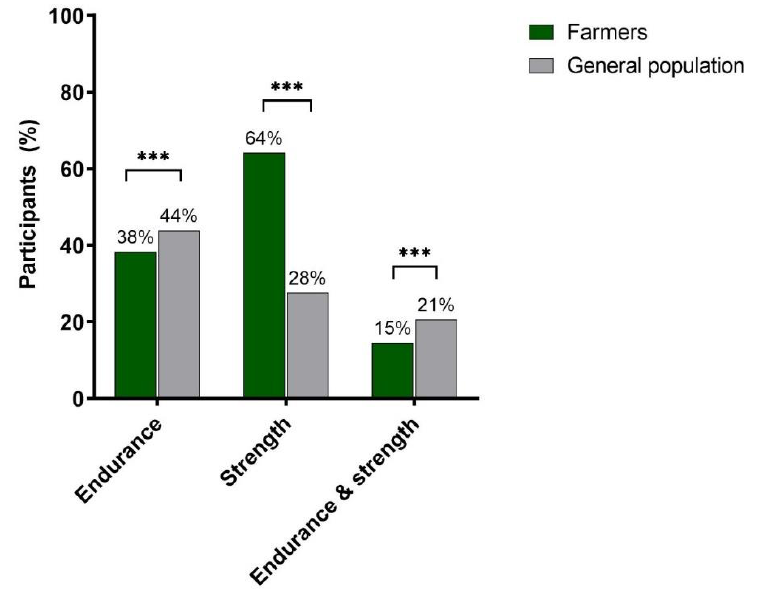
Figure 3. Participants’ percentage of recommendations’ fulfillment for physical activity. Notes: *** significant differences, which were calculated using Chi-Square Tests. Endurance recommendations were categorized as fulfilled ( ≥ 150 min/week) and not fulfilled (<150 min/week). Strength training was divided into fulfilled ( ≥ 2 x/week) and not fulfilled (<2 x/week) [8].